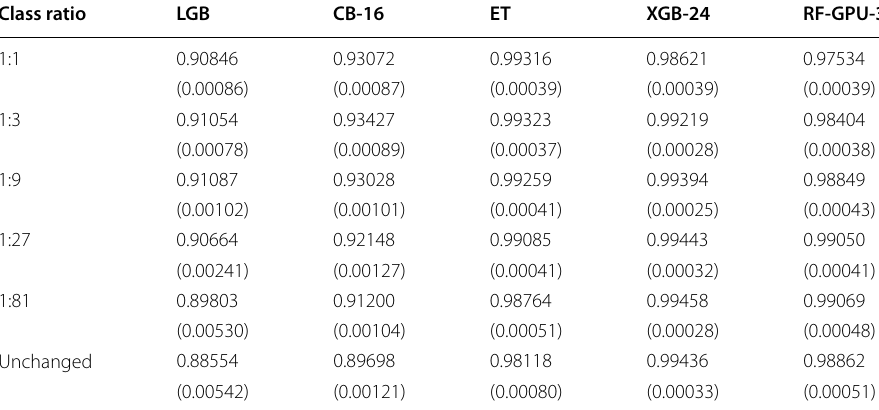
Table 7 Part-B mean and standard deviation of AUC with varying levels of RUS (10 iterations of fivefold